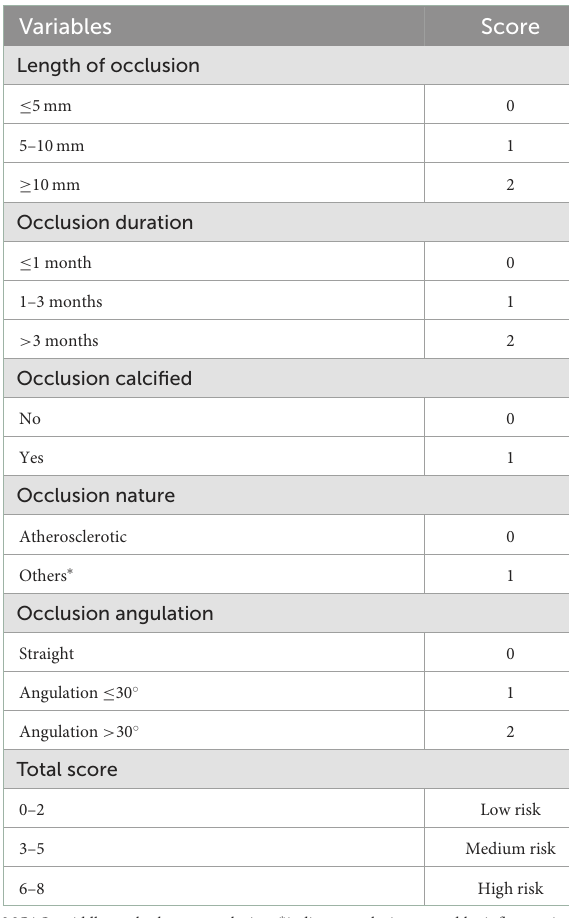
TABLE 1 Scores for successful recanalization of non-acute symptomatic